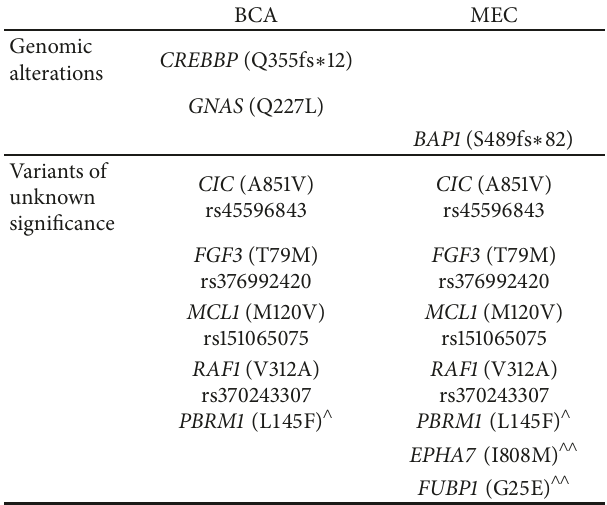
Table 1: Gene alterations in BCA and MEC